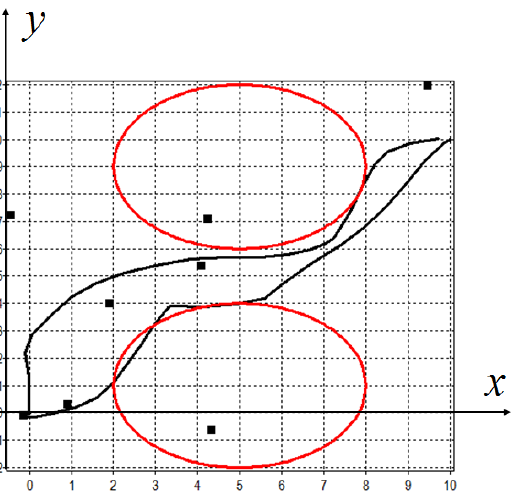
Figure 3. Optimal trajectories of robots on the plane { x , y } for synthesized control with B =